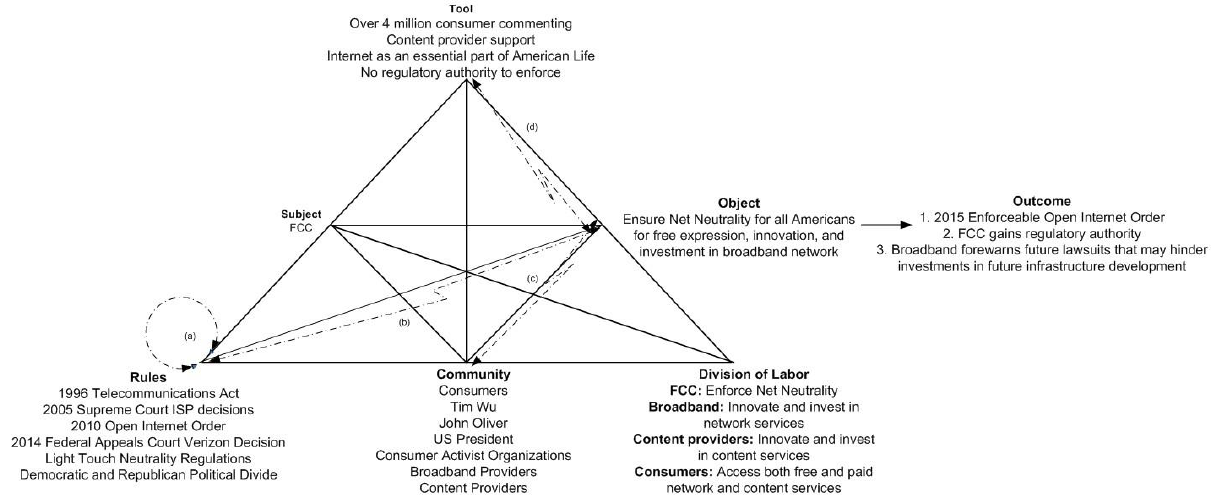
Figure 2. Analysis of the 2015 FCC Open Internet Order Activity. A previous version of the figure was published in Yamagata-Lynch et al. (2017)